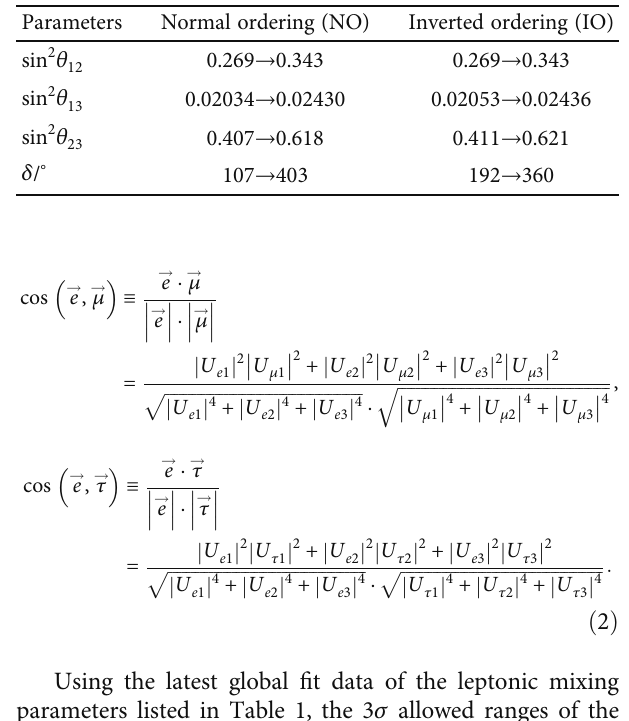
Table 1: The 3 σ allowed ranges of the leptonic mixing parameters in the global analysis NuFIT 5.0